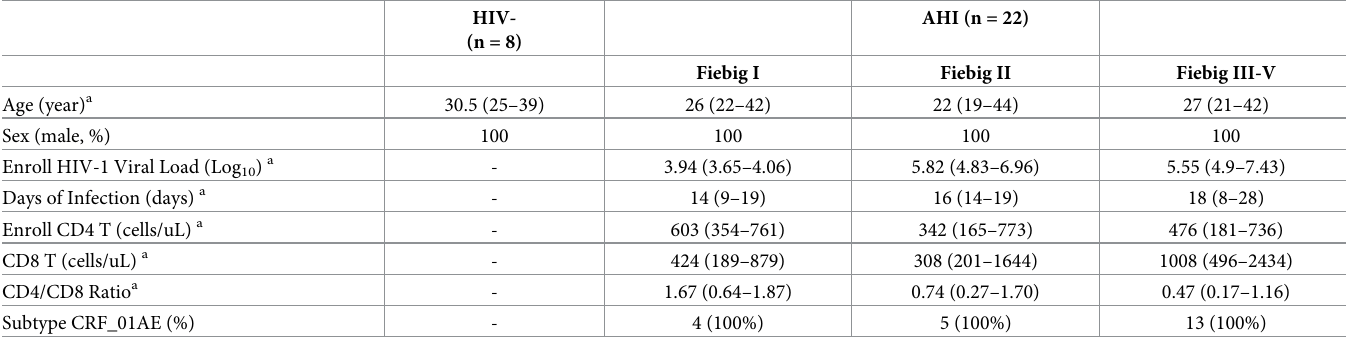
Table 1. Clinical characteristics of study participants upon diagnosis and